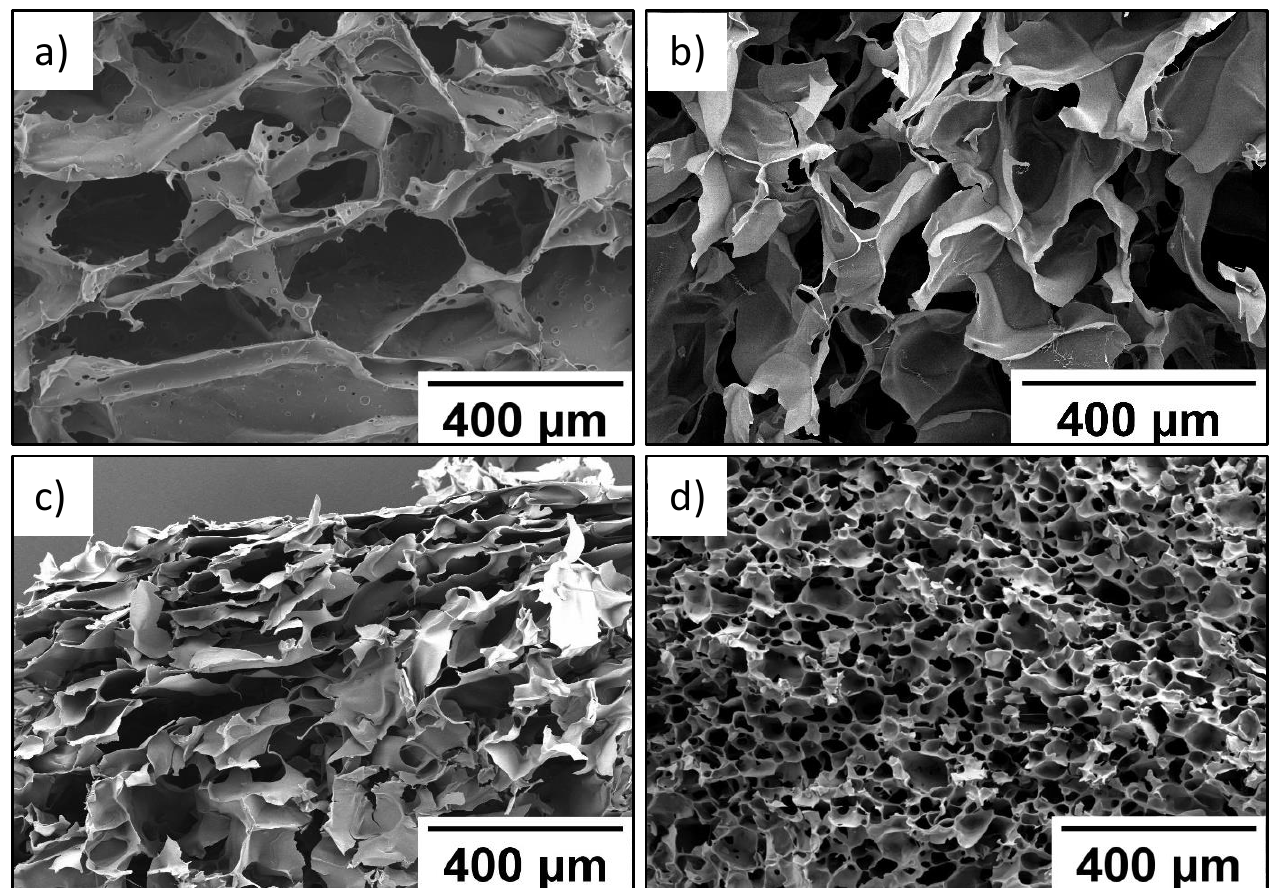
Figure 1. SEM images of P(SPM-VA) ( a ), P(SPM-HEMA) ( b ), P(SBMA-HEMA) ( c ), and P(SBMA-VA) ( d ) gels.